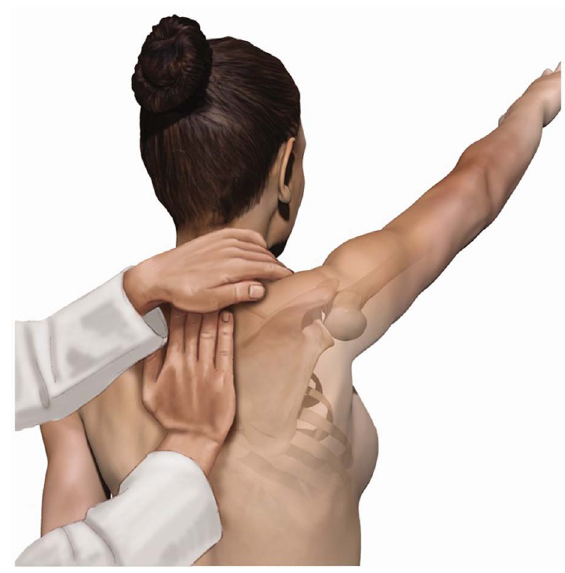
Figure 3. The scapular reposition (retraction) test (SRT) a manually assisted examination manoeuvre.